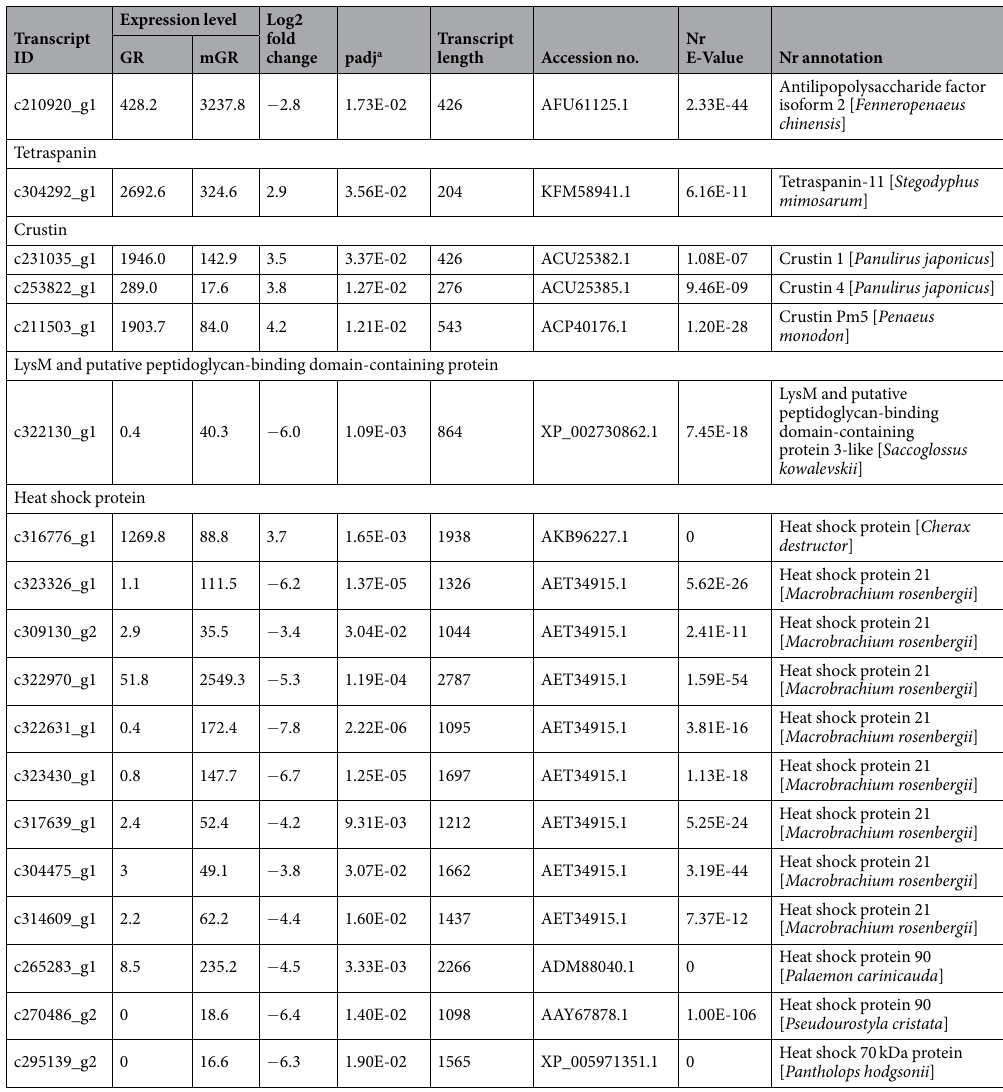
possesses a highly conserved LysM domain and a less conserved transmembrane region; however, the amino acid sequence of c322130_g1 showed low levels of identity ( ≤ 24.7%) with the LYSMD sequences in NCBI (Fig. S4). Heat shock proteins (Hsps) are classified into six families based on their molecular weights (kDa), i.e., Hsp100, Hsp90, Hsp70, Hsp60, Hsp40, and small Hsps 26 . In the present study, 12 Hsp-encoding unigenes were differen- tially expressed between GR and mGR. Of these genes, eight Hsp21, two Hsp90, and one Hsp70 were downregu- lated in GR, whereas one unigene annotated as Hsp70 was upregulated in GR (Table